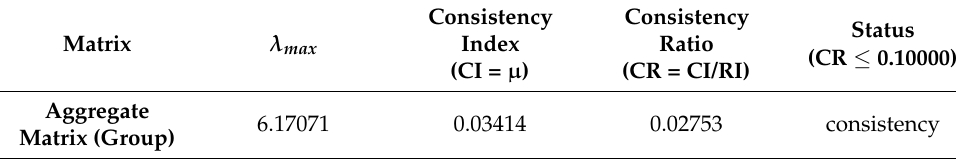
Table 17. Consistency analysis of the aggregate matrix.